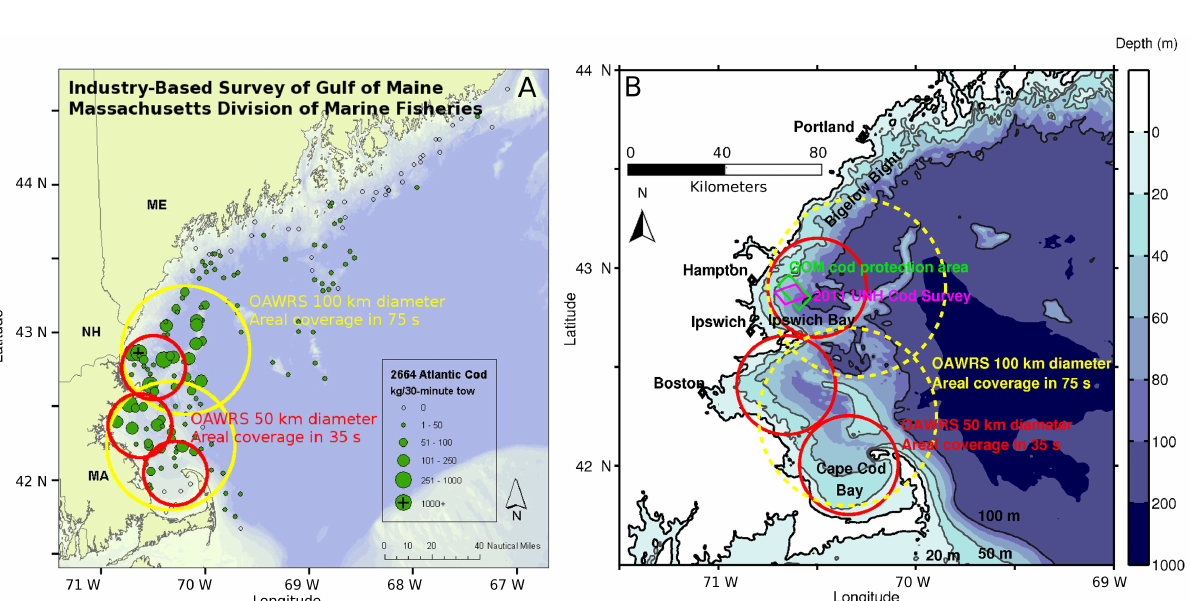
Figure 6. ( A ) Distribution of cod spawning populations during the Industry-Based Survey for Gulf of Maine Cod conducted by the Massachusetts Division of Marine Fisheries in 2006 [69] with the typical OAWRS areal coverage of 100 km in 75 s and 50 km in 35 s. ( B ) Bathymetry of the region off the coast of Massachusetts and the typical OAWRS areal coverage of 100 km in 75 s and 50 km in 35 s. The Gulf of Maine cod spawning protection area [34] and May–June, 2011, University of New Hampshire Cod Survey area [32,33] falls in the Ipswich Bay, off the coast of Massachusetts and New Hampshire. A towed receiver array typically employed in OAWRS moves along tracks that would run between the centers of the shown circles and produce effectively continuous overlapping imaging windows in